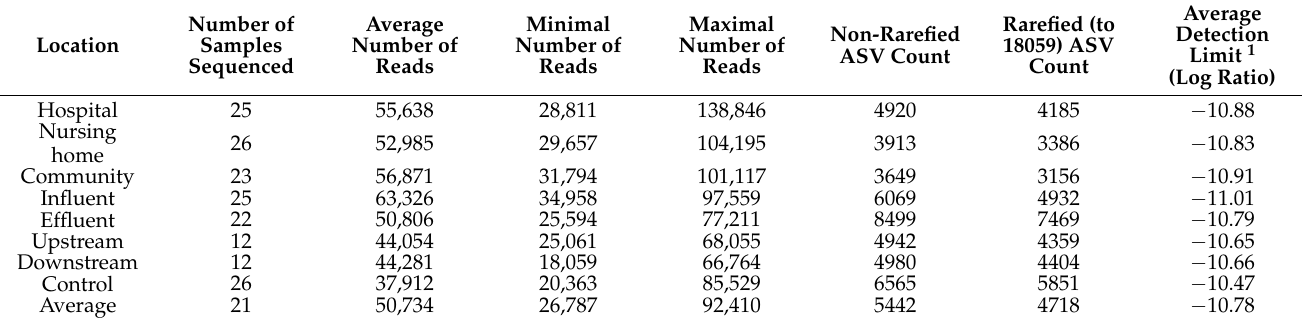
1 The log ratio of the detection limit per sample is calculated by: log(1)—log(total number of